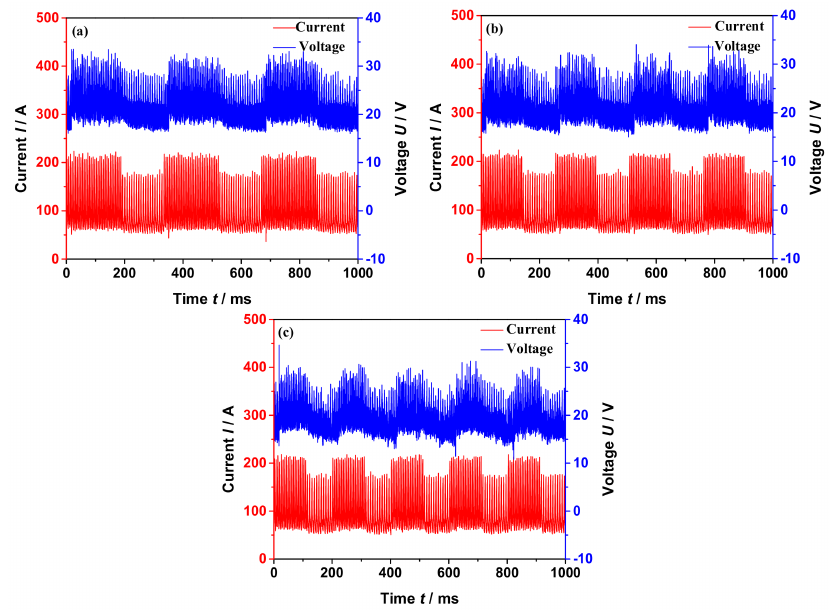
Figure 4. Transient electrical signal waveforms of DP-GMAW: ( a ) 3 Hz; ( b ) 4 Hz; and, ( c ) 5